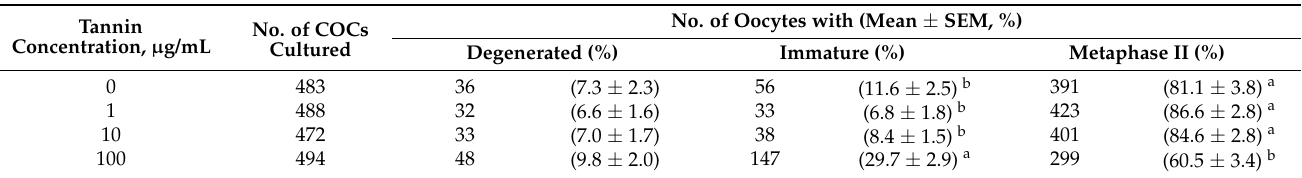
Table 2. Effects of tannin on porcine oocyte maturation during in vitro